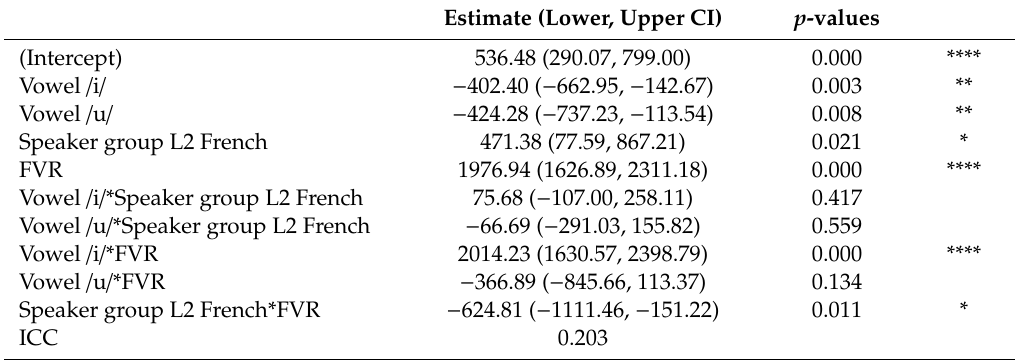
Table 2. Mixed-e ff ects linear regression model for COG at Timepoint 1.